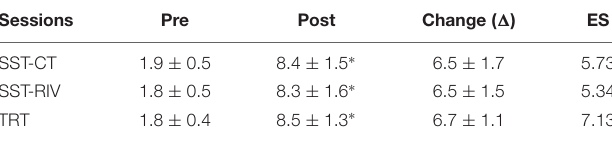
TABLE 2 | Mean ± SD, percentage of change, and effect size (ES) of blood lactate pre and post sarcoplasma stimulating training contraction type (SST-CT), SST rest interval variable (SST-RIV), and traditional resistance training (TRT)